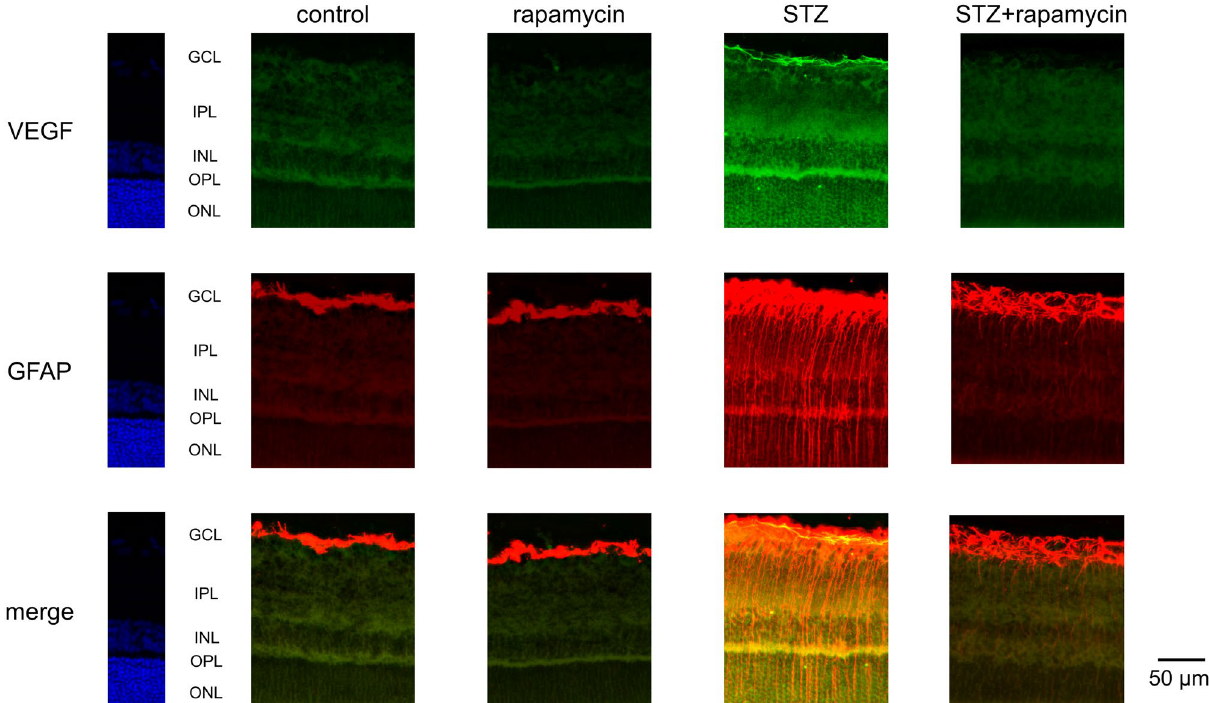
Figure 1. Representative photomicrographs of retinal tissues stained immunohistochemically with anti-VEGF (green) and anti-GFAP (red) antibodies. VEGF immunoreactivity was higher in the diabetic retina sections than in the control retinas, and expression of VEGF was colocalized with GFAP.